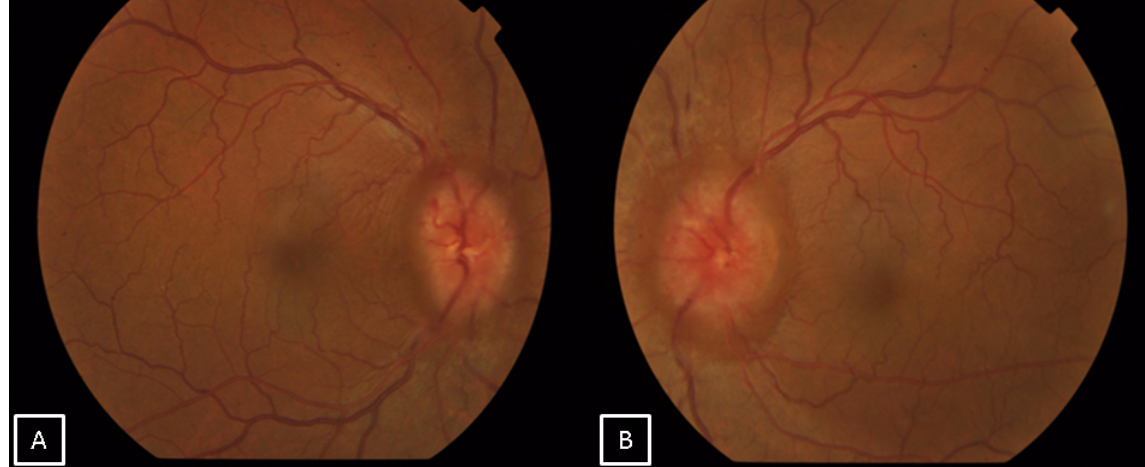
Figure 1: Fundus pictures of the right (A) and left eye (B) showing bilateral optic disc edema suggestive of papilledema